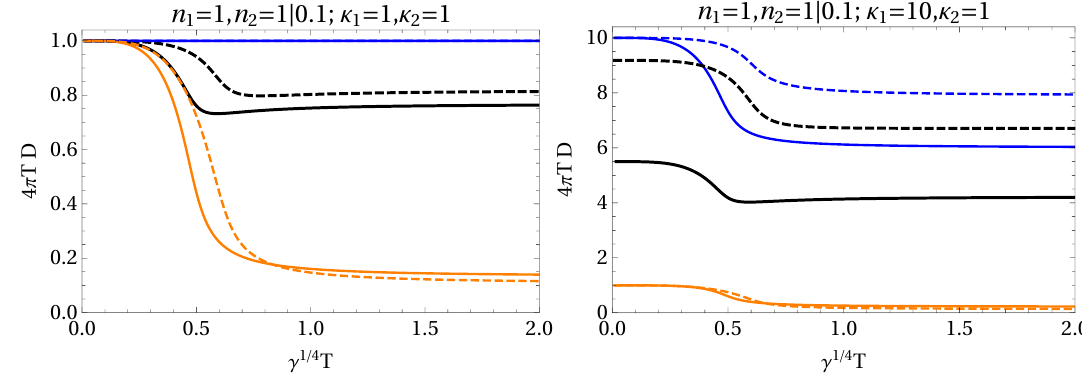
Figure 8 . Shear di(cid:11)usion constants D a;b (blue and orange lines) corresponding to shear eigenmodes in the hybrid (cid:13)uid model for di(cid:11)erent parameters as a function of (cid:13) 1 = 4 T compared to the overall (Kubo) shear di(cid:11)usion constant D (red lines) corresponding to the total shear viscosity (cid:17)= S (cid:17) T D . Full and dashed lines correspond to equal numbers of degrees of freedom, n 1 = n 2 = 1, and unequal ones, n 1 = 1 ; n 2 = 1 = 10, respectively. The left panel has equal values of individual shear viscosities (cid:20) i = 4 (cid:25)(cid:17) i =s i = 1, the right panel has (cid:20) 1 = 10 so that the (cid:12)rst system corresponds to a more weakly coupled sector.